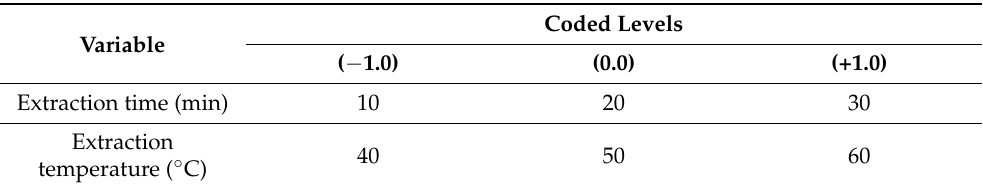
Table 1. Levels of the variables (extraction time and extraction temperature) explored in the face- centred composite experimental design experiments